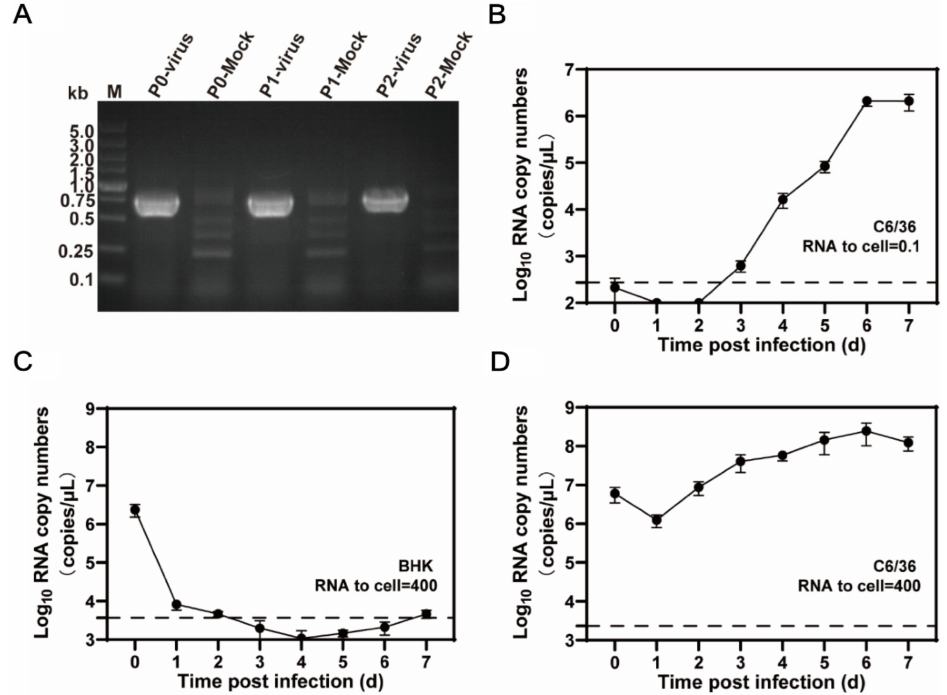
Figure 4. Rescue and characteristics of rescued MFV (rMFV) YN15-283-02 in vitro. ( A ) Detection of viral genome in cellular total RNA of P0 to P2. Total RNA from the infected and naïve cells was extracted and subjected to RT-PCR detection using the primers within the NS1 gene. The resulting RT-PCR products were resolved via 1% agarose gel electrophoresis. ( B ) Growth kinetics of rMFV YN15-283-02 in C6/36 cells. C6/36 cells were infected at a ratio of viral RNA copies to cell number